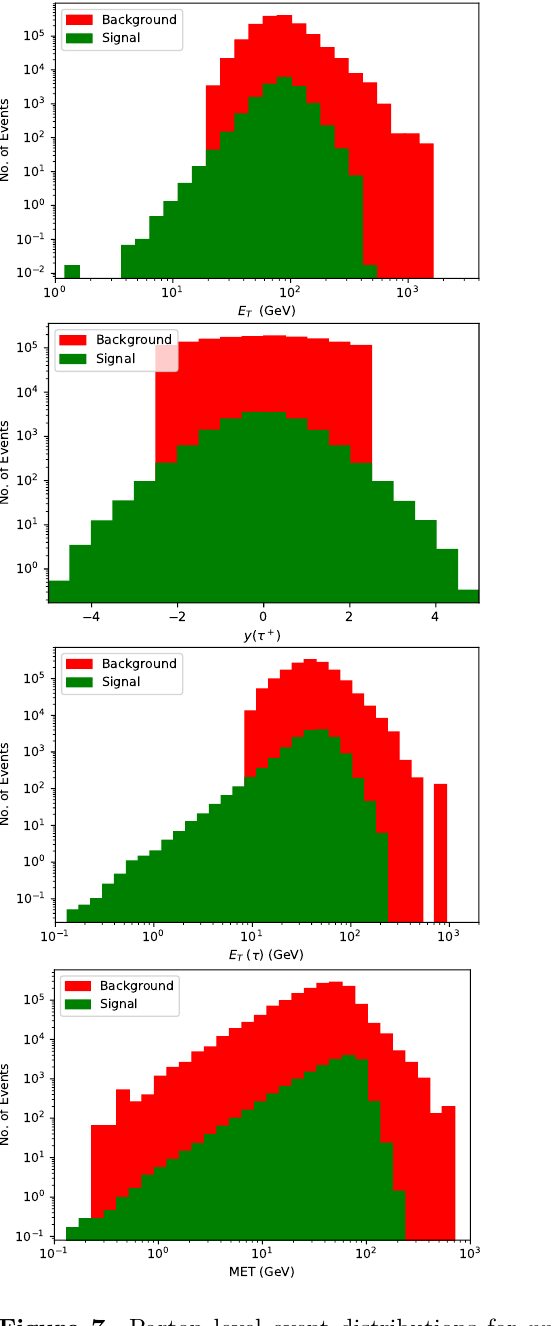
H − → n τ n τ ττ for BP3 normalized to 2 2 , before cuts. (Right column, top to bottom): T